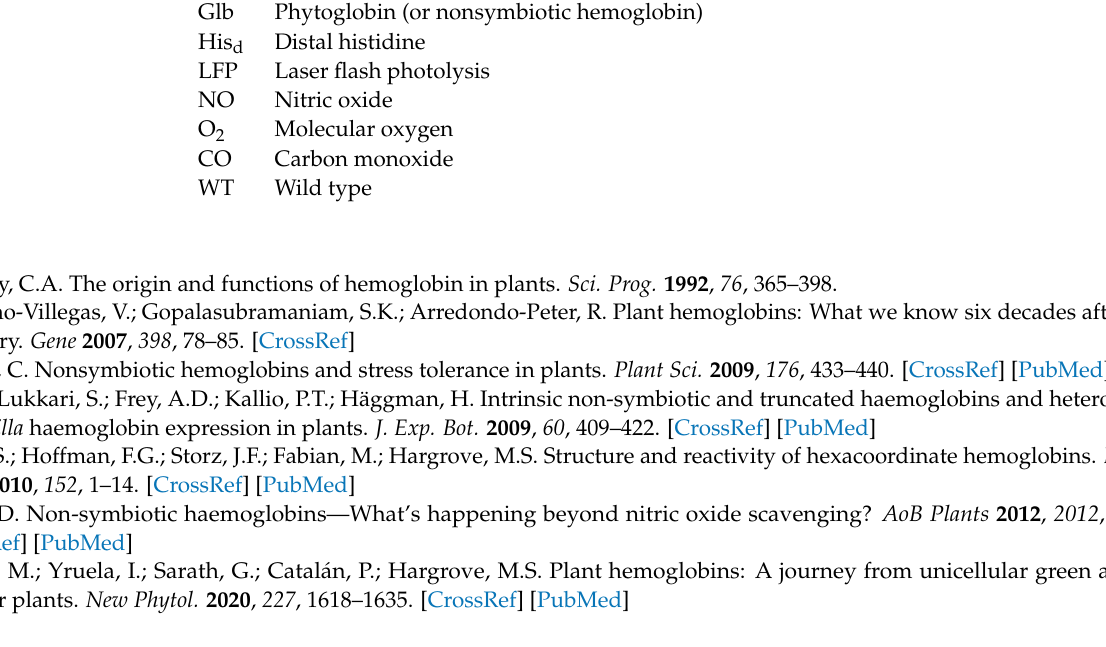
and WT4. Figure S3: Arrhenius plots for the rate constants obtained from the analysis of nanosecond LFP data of WT1 and WT4. Table S1: Lifetimes from the fit of nanosecond LFP data at 40 ◦ C at 1 atm and 0.1 atm CO for WT1 and WT4 and their mutants, using a sum of exponential decay functions. Table S2: Lifetimes from the fit of hybrid pump–probe data at room temperature at 1 CO atm for WT1 and WT4, using a sum of exponential decay